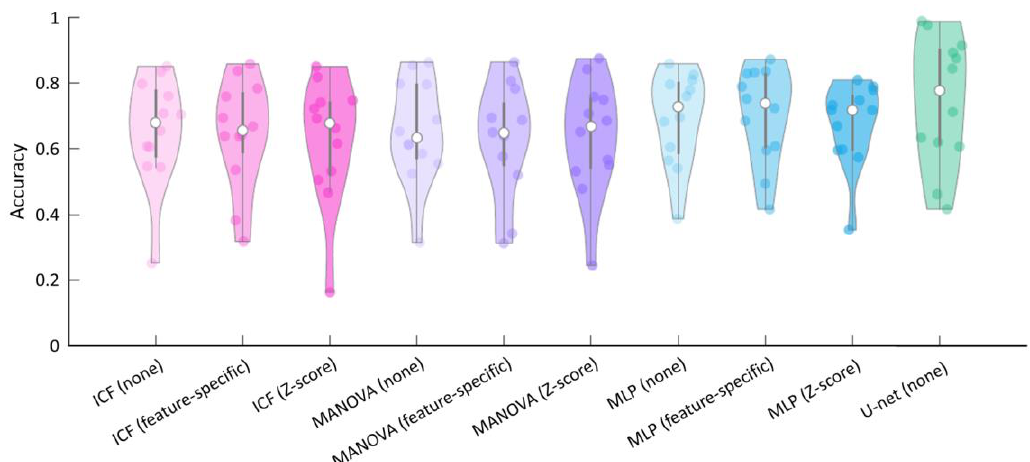
Figure 6. Violin plots showing the accuracies of the individual cell features (ICFs), the multivariate analysis of variance (MANOVA), and the multilayer perceptron (MLP) models with different normal- isation methods and the U-net in terms of agreement with the independent pathologists’ assignments. Coloured dots in the violin plots correspond to the individual accuracies of HCC samples. Median accuracies for all samples are indicated by the white dots. Thick grey bars in the centre represent the interquartile